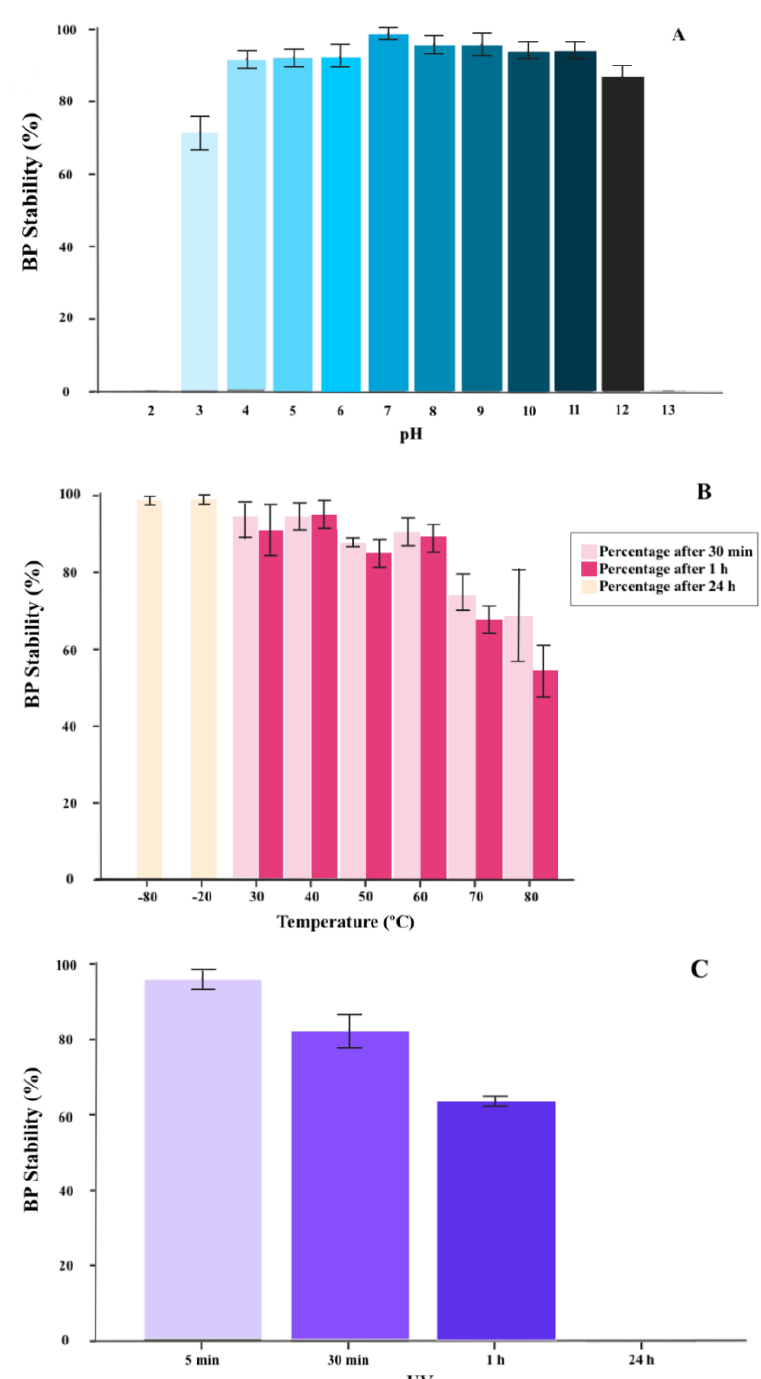
Figure 1. Stability of FGS011 exposed to different stress conditions. ( A ) pH stability of FGS011; ( B ) thermal stability of FGS011; and ( C ) stability upon exposure to UV radiation of FGS011. Data reported are means ± standard error of three independent trials. Error bars show standard